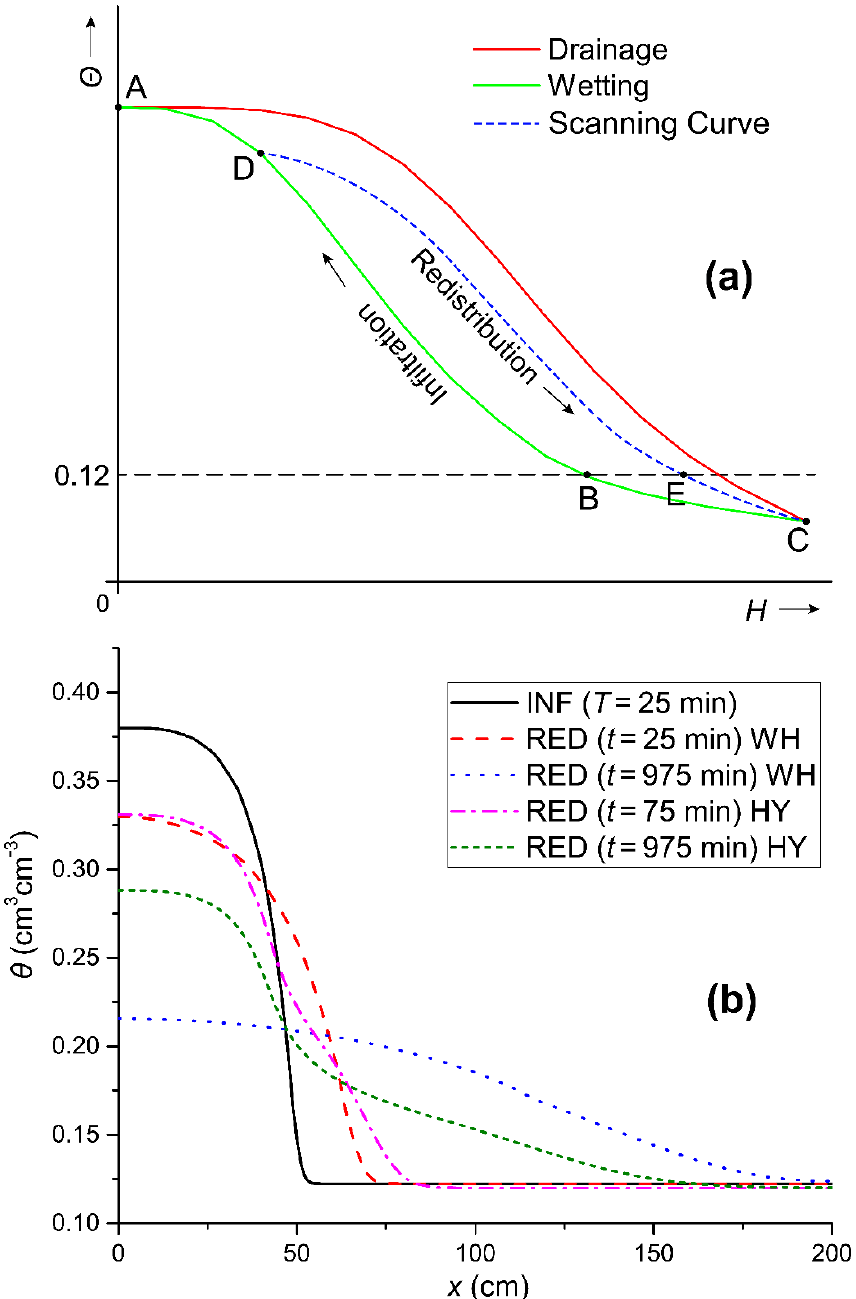
Figure 2. Schematic representation of the boundary drainage and wetting curves and the pathways followed during infiltration and redistribution in the case where the initial water content lies on the boundary wetting curve ( a ). The θ (x) relationship for the horizontal infiltration (INF) with initial soil water content θ 0 = 0.12 cm 3 cm − 3 and for T = 25 min and for the redistribution (RED) when hysteresis was considered (HY) and without hysteresis (WH), making use of the boundary wetting H– θ curve for redistribution times: 25 min (WH) and 75 min (HY) and 975 min for (WH) and (HY) ( b ). For a better understanding of the effect of hysteresis on soil water redistribution, the pressure head gradient in the pressure head profiles during the redistribution were examined. In Figure 3, it can be observed that the soil water pressure head gradient dH the presence of hysteresis at time t = 25 min tended to the value of zero, which explains the small magnitude of the redistribution rate in all later stages—although the values of K